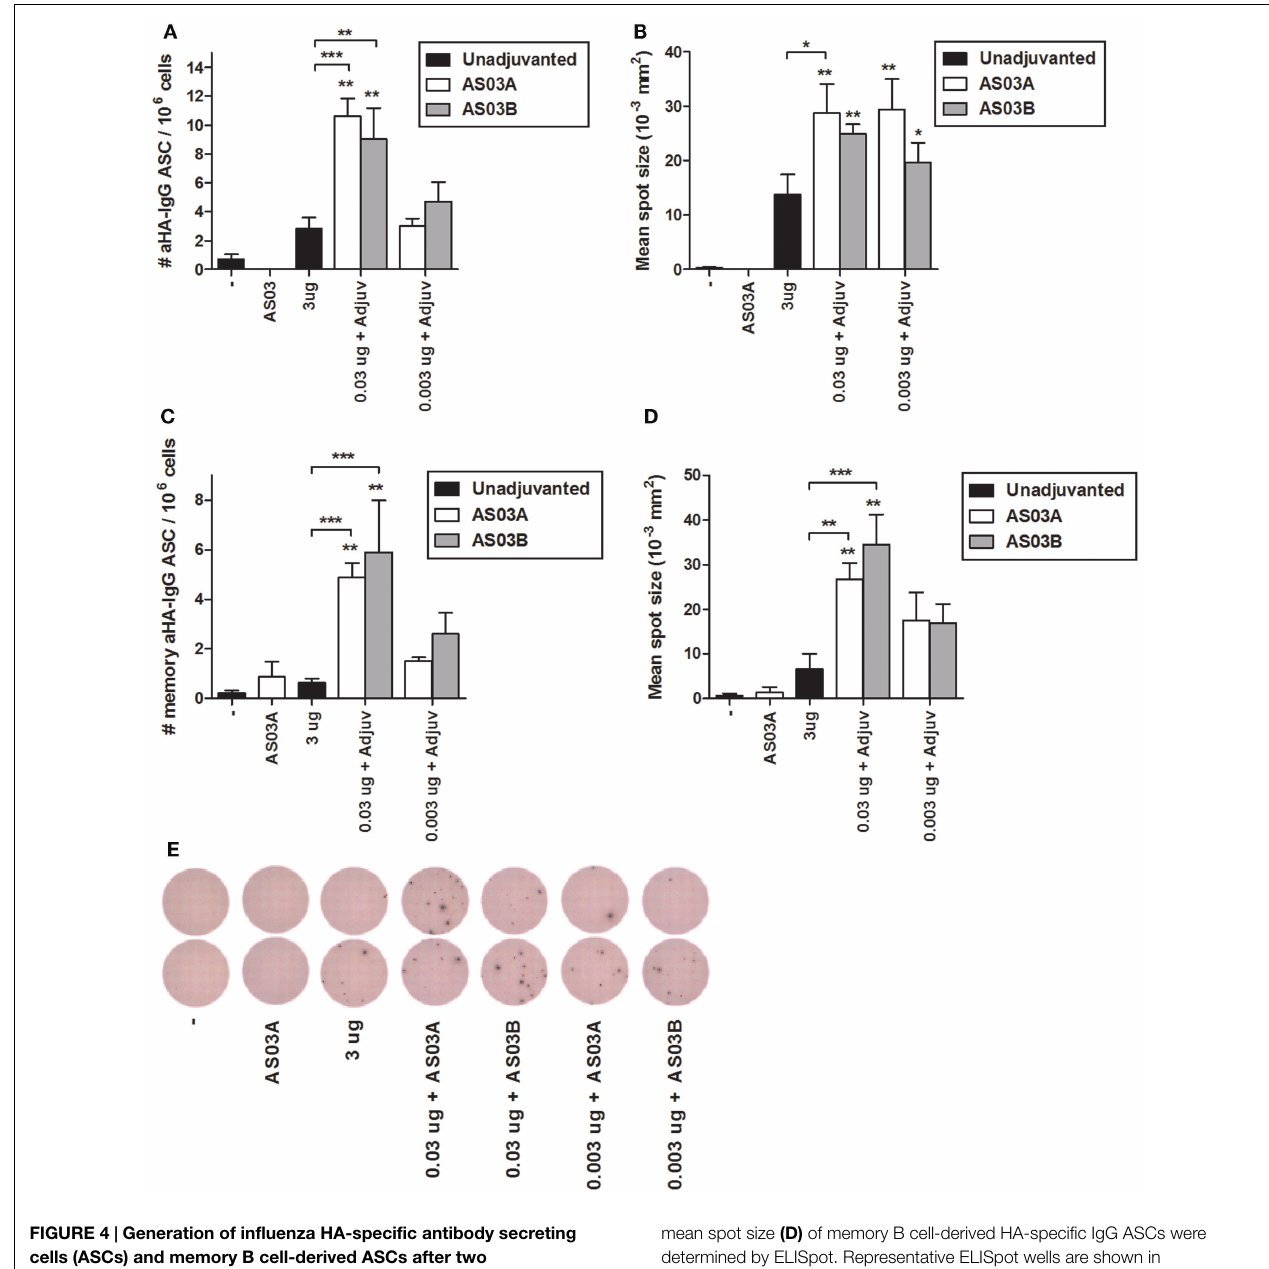
FIGURE 4 | Generation of influenza HA-specific antibody secreting cells (ASCs) and memory B cell-derived ASCs after two immunizations of unadjuvanted A/Uruguay/716/2007 H3N2 split vaccine or AS03-adjuvanted dose-sparing vaccines . BALB/c mice were immunized intramuscularly on days 0 and 21, and splenocytes were isolated from individual mice on day 42. The number (A) and mean spot size (B) of HA-specific IgG antibody secreting cells (ASCs) were determined by ELISpot. Following ex vivo stimulation, the number (C) and